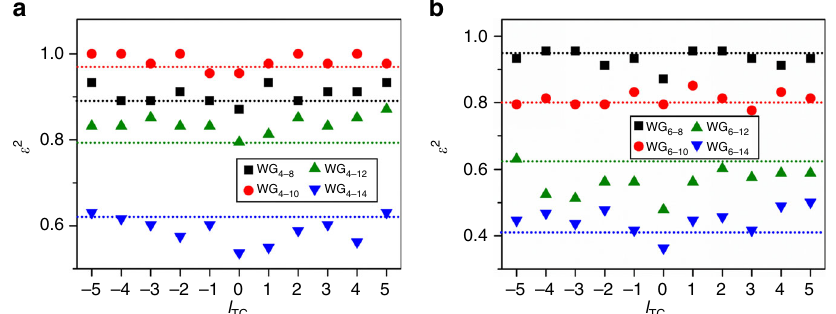
Fig. 4 Characterization of average polarization state in CVVs. a , b Measured squared polarization ellipticity ε 2 (solid markers) of the CVVs from the devices of height 0.4 and 0.6 μ m, respectively. The prediction of κ 2 from numerical calculations is plotted with dashed lines, and the measured and calculated results for the same device are marked in the same